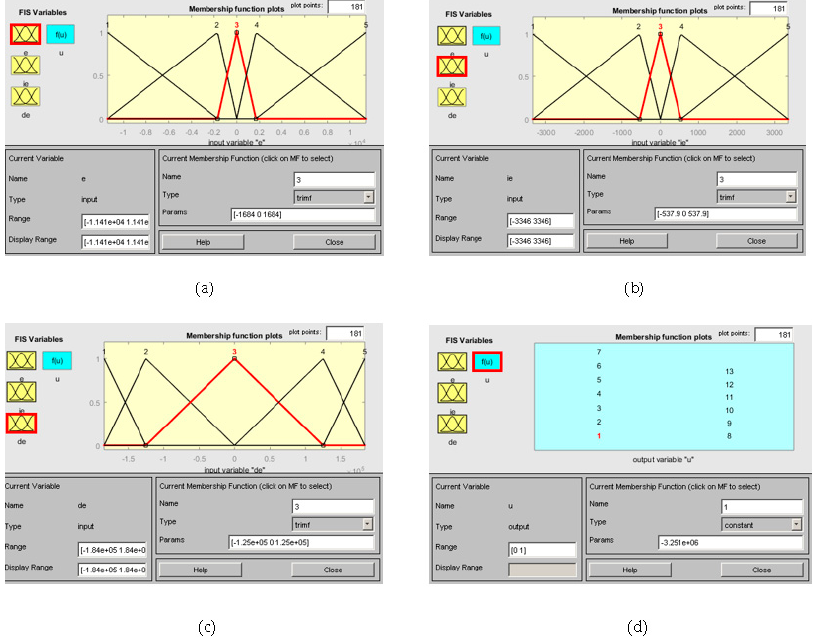
(cid:82) . e ( t ) ; ( c ) e ( t ) ; and ( d ) u ( t ) in Matlab.